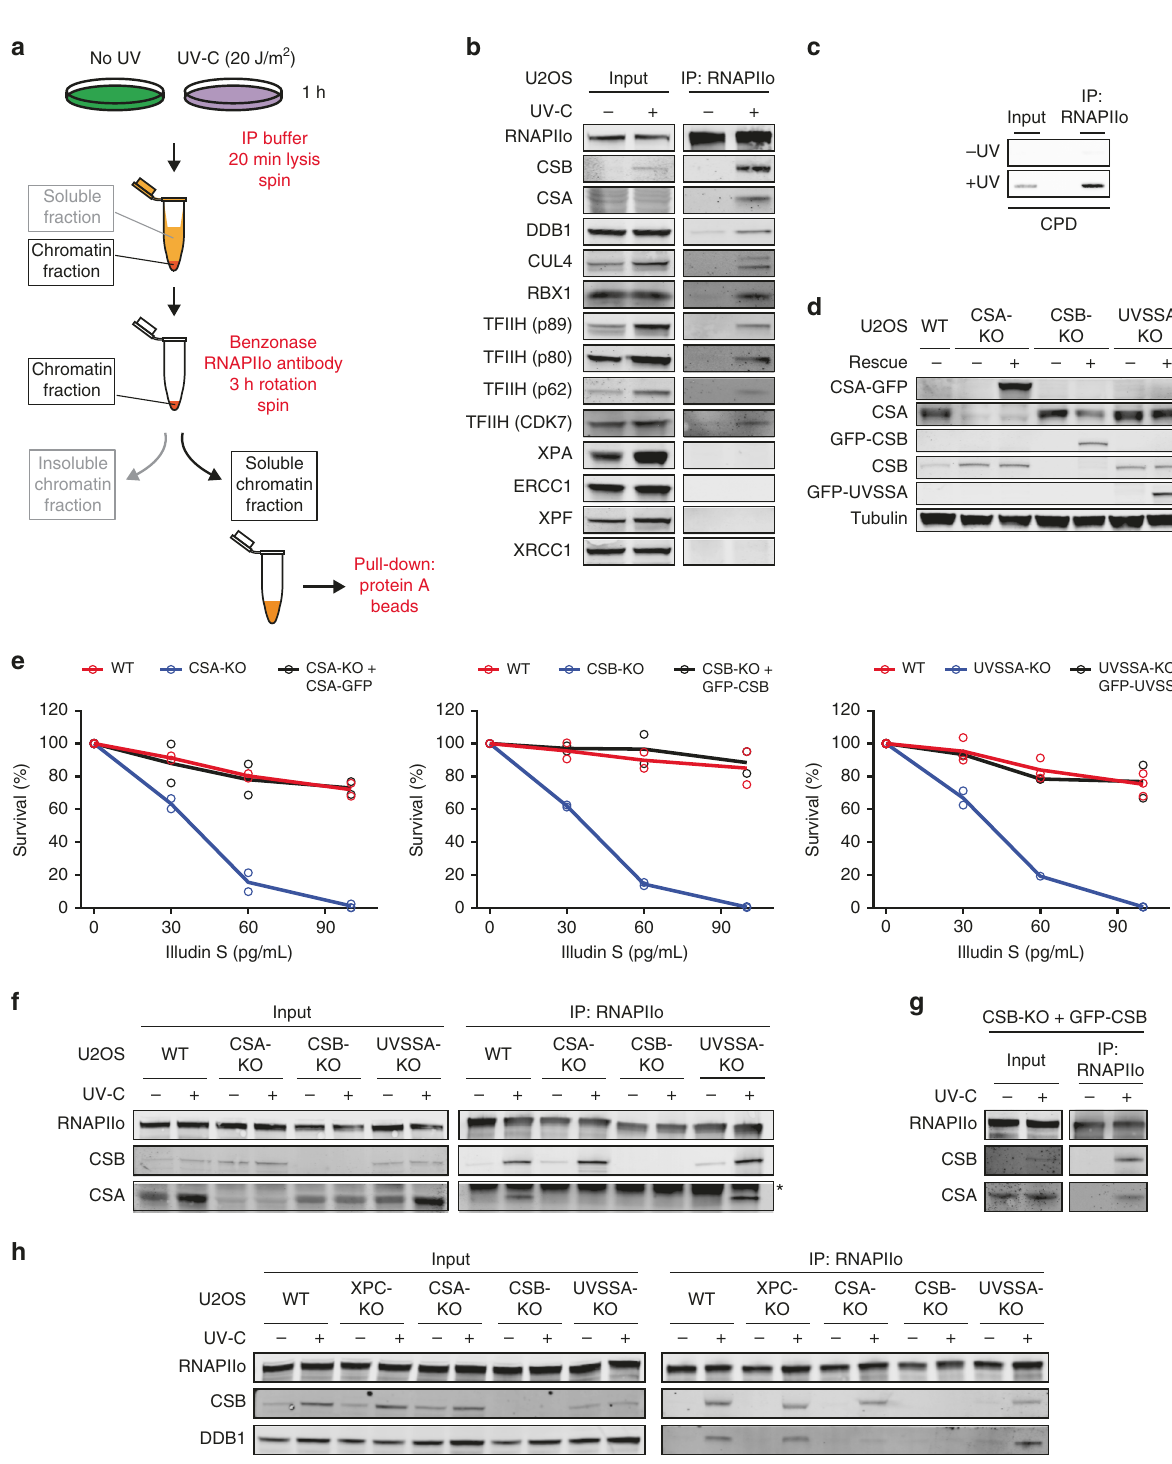
Fig. 1 CSA is recruited to DNA damage-stalled RNAPIIo by CSB. a Outline of a new IP method to isolate RNAPIIo and associated proteins from mock- treated or UV-irradiated (20 J/m 2 ) U2OS (FRT) cells. b Endogenous RNAPII Co-IPs on WT cells stained for the indicated TCR proteins. Note that it is not possible to stain for all these proteins on one membrane. This panel is a composite of several representative Co-IPs. See Supplementary Fig. 1a for each individual Co-IP. c Endogenous RNAPII Co-IP followed by slot blot analysis of CPDs d Western blot analysis of CSA, CSB, and UVSSA knockout cells complemented with inducible GFP-tagged versions of these proteins ( n = 2). See Supplementary Fig. 2a, b for validation of knockouts by sequencing. e Clonogenic Illudin S survival of WT, CSA, CSB, and UVSSA knockout and rescue cell lines. Each symbol represents the mean of an independent experiment ( n = 2 for all except for WT in UVSSA-KO fi gure which is n = 3) each experiment contains two or three technical replicates. Endogenous RNAPII Co-IP on f WT, CSA, CSB, and UVSSA knockout cells, g CSB-KO stably expressing GFP-CSB, and h WT, XPC, CSA, CSB, and UVSSA knockout cells. The asterisk in e indicates the heavy chain of the RNAPII antibody. At least two independent replicates of each IP experiment were performed obtaining similar results. Source data are provided as a Source Data fi